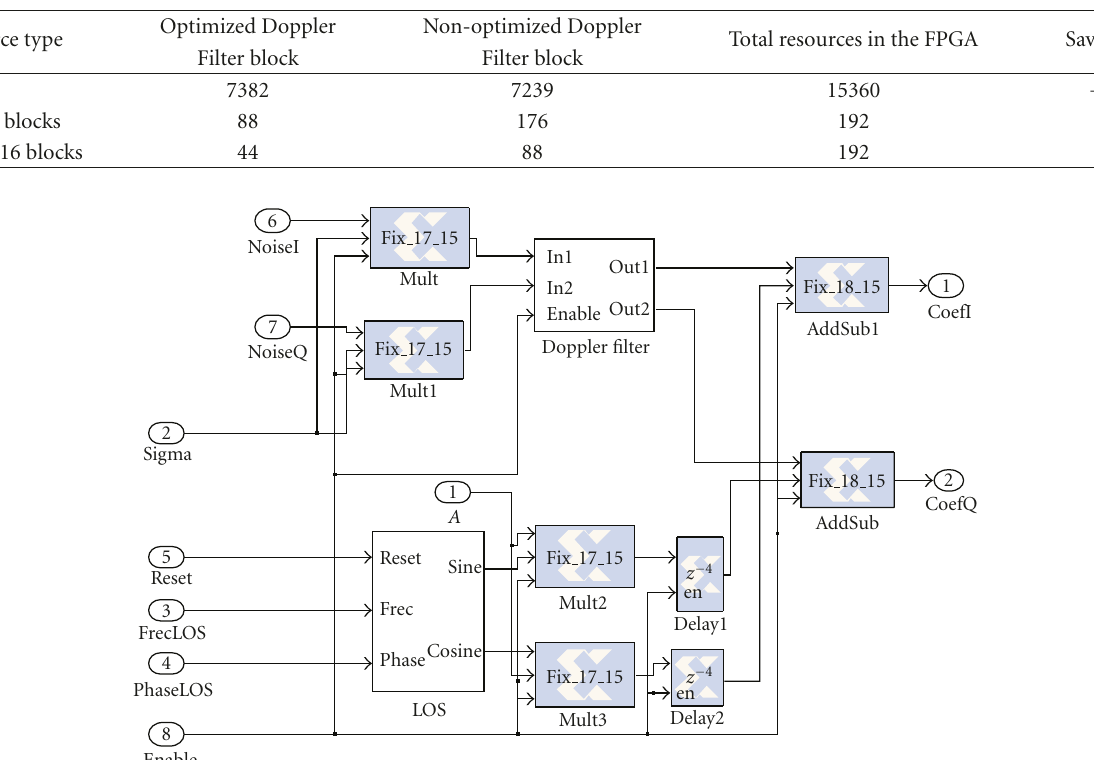
Table 4: Savings due to the optimization of the Doppler filter block.